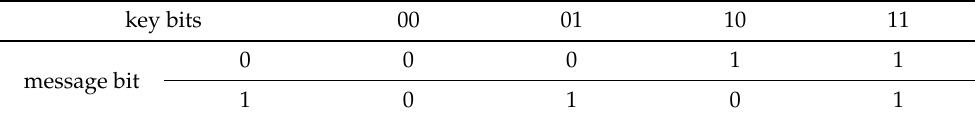
Table 1. Example for the authentication of one